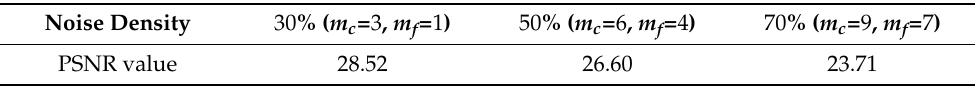
Table 10. The average value of PSNR for setting the parameters of stop iteration by referring to Table 2.